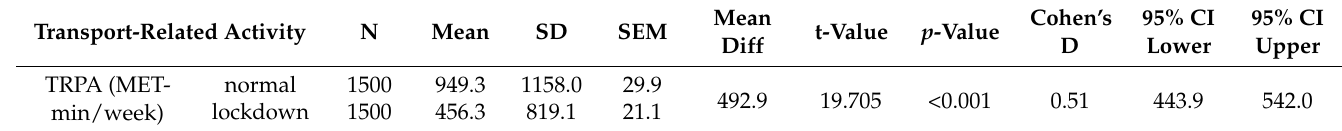
Table 6. Transport-related activity MET-minutes per week.